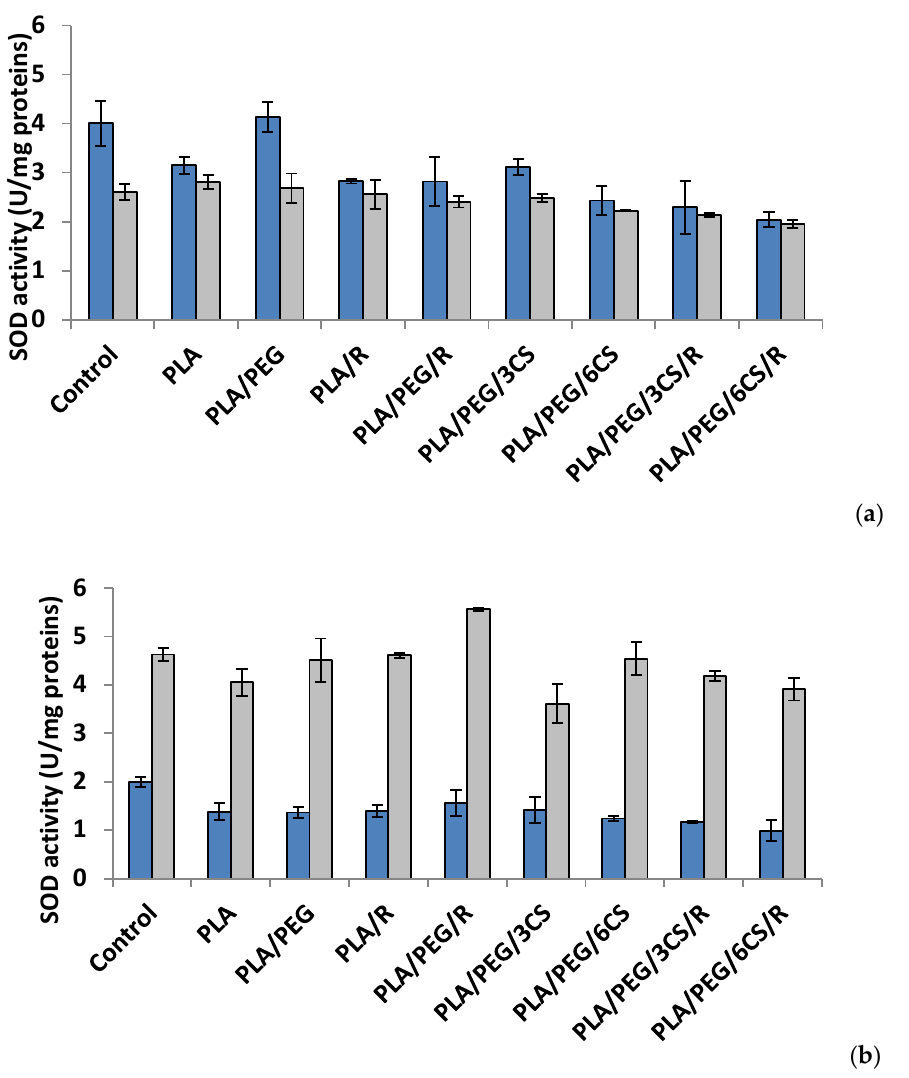
Figure 4. Superoxid dismutase (SOD) activity in P. chrysosporium ( dark blue columns ) and C. globosum ( grey columns ) after 7 days ( a ) and 14 days ( b ) of incubation in the presence of PLA-based samples.